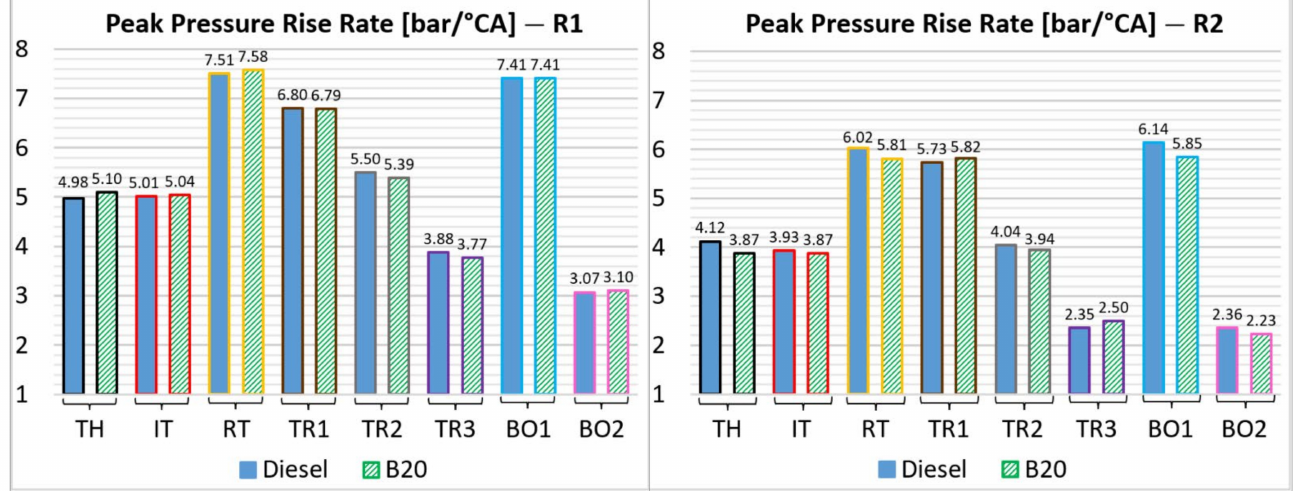
Figure 10. Peak in-cylinder pressure rise rate variation by different shapes of